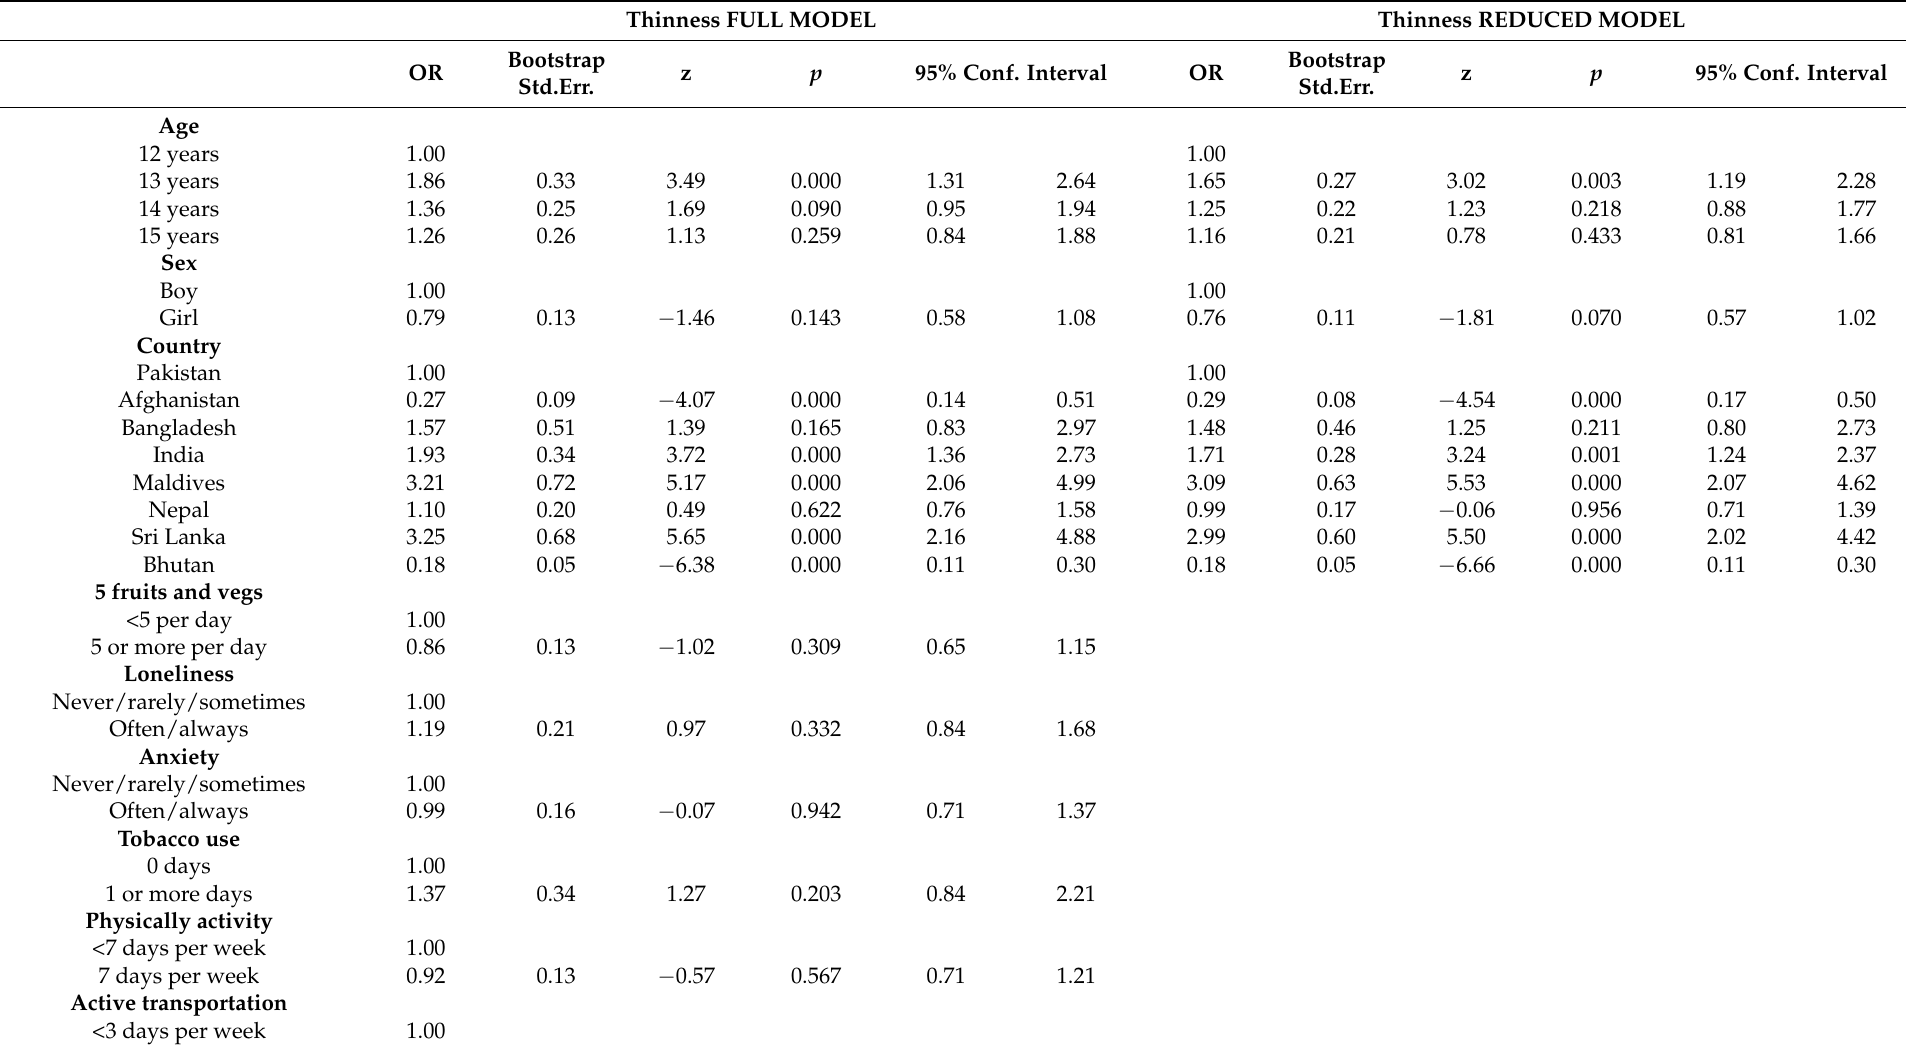
Table 7. Multivariable logistic regression model for adolescent thinness in South Asia, GSHS